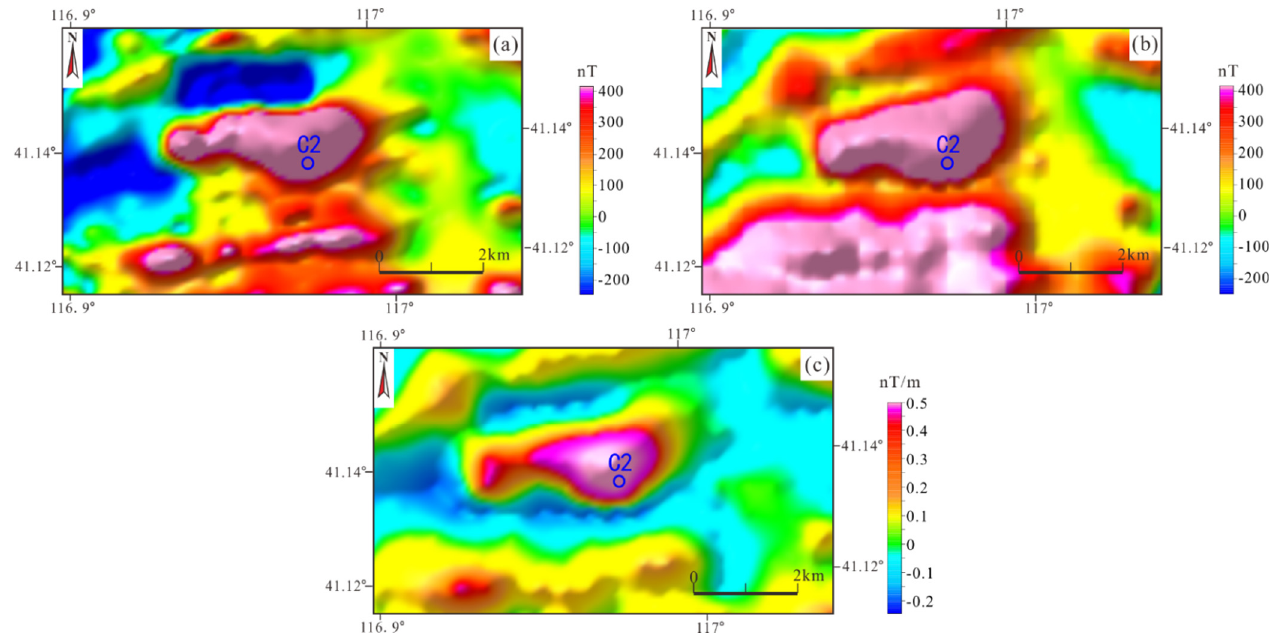
Figure 5. Aeromagnetic anomaly and its conversion of some magmatic rock magnetite in the study area: ( a ) Aeromagnetic data ∆ T, ( b ) reduction to the pole of aeromagnetic data ∆ T, ( c ) the first vertical derivative of reduction to the pole of aeromagnetic data ∆ T.